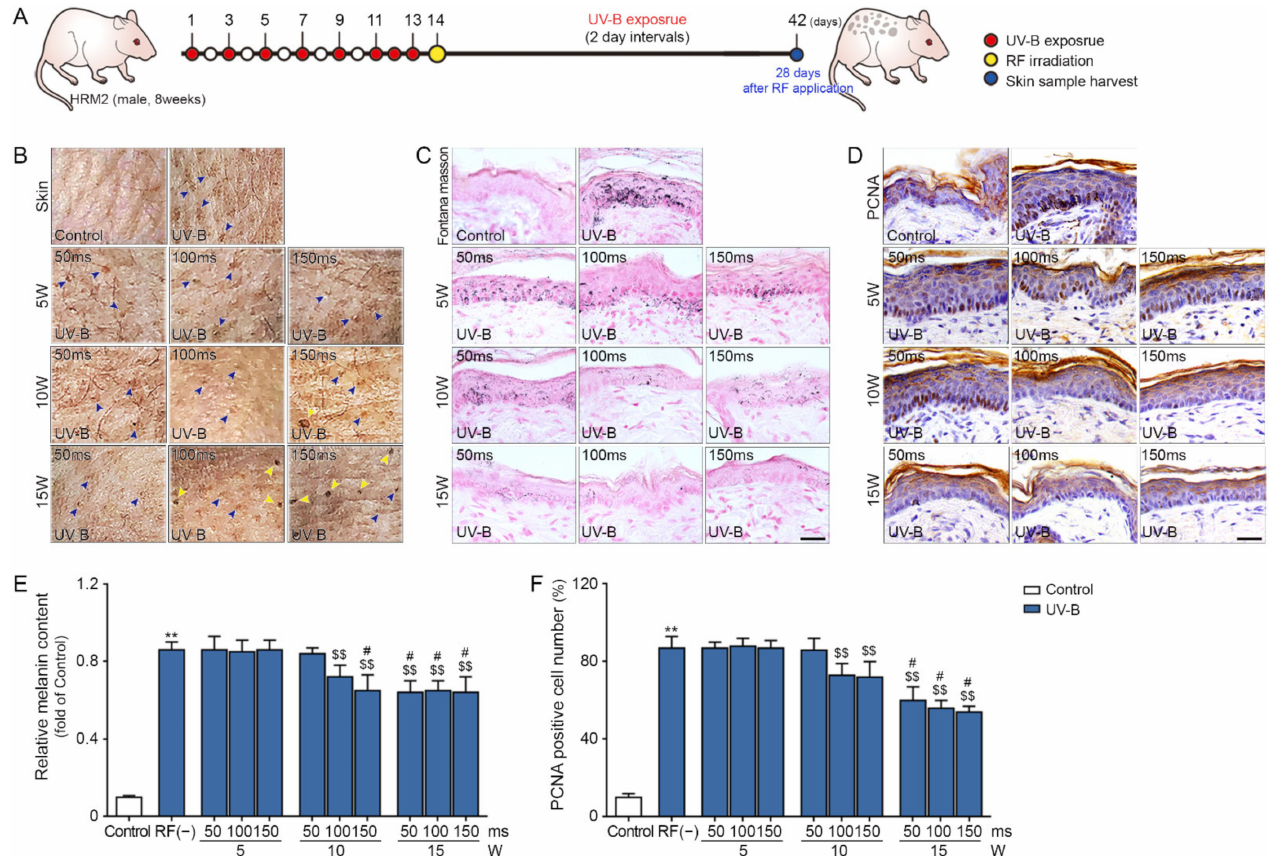
Figure 1. Decreased melanin accumulation due to RF in the UV-B exposed skin. ( A ) Diagram of the animal model used to validate the melanin reduction mechanism. ( B ) Change in animal skin according to power of RF irradiation. ( C , E ) Change in Fontana–Masson staining of skin tissue according to power of RF irradiation. ( D , F ) Change in PCNA positive skin tissue cells according to power of RF irradiation. PCNA, proliferating cell nuclear antigen; RF, radiofrequency; UV-B, ultraviolet-B; **: p < 0.01 vs. control; $$: p < 0.01 vs. UV-B/RF ( − ); #: p < 0.05 vs. UV-B/RF 10 W/100